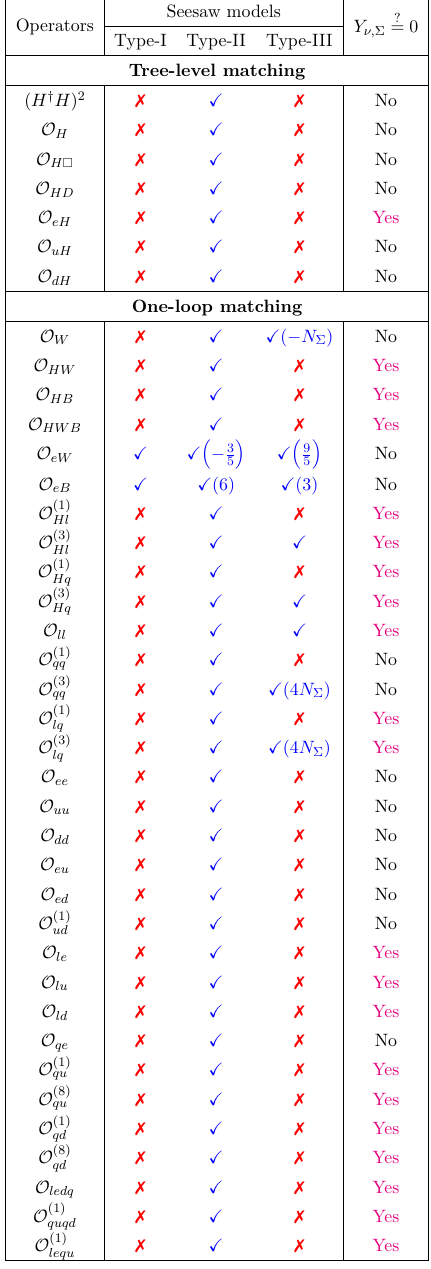
Table 12 . Check-marks (cross-marks) in blue (red) mean that operators in the first column can (cannot) be induced from the specific seesaw model. Flavor indices are implicit following the nota- tions in [57]. The last column specifies whether we assume vanishing neutrino Yukawa